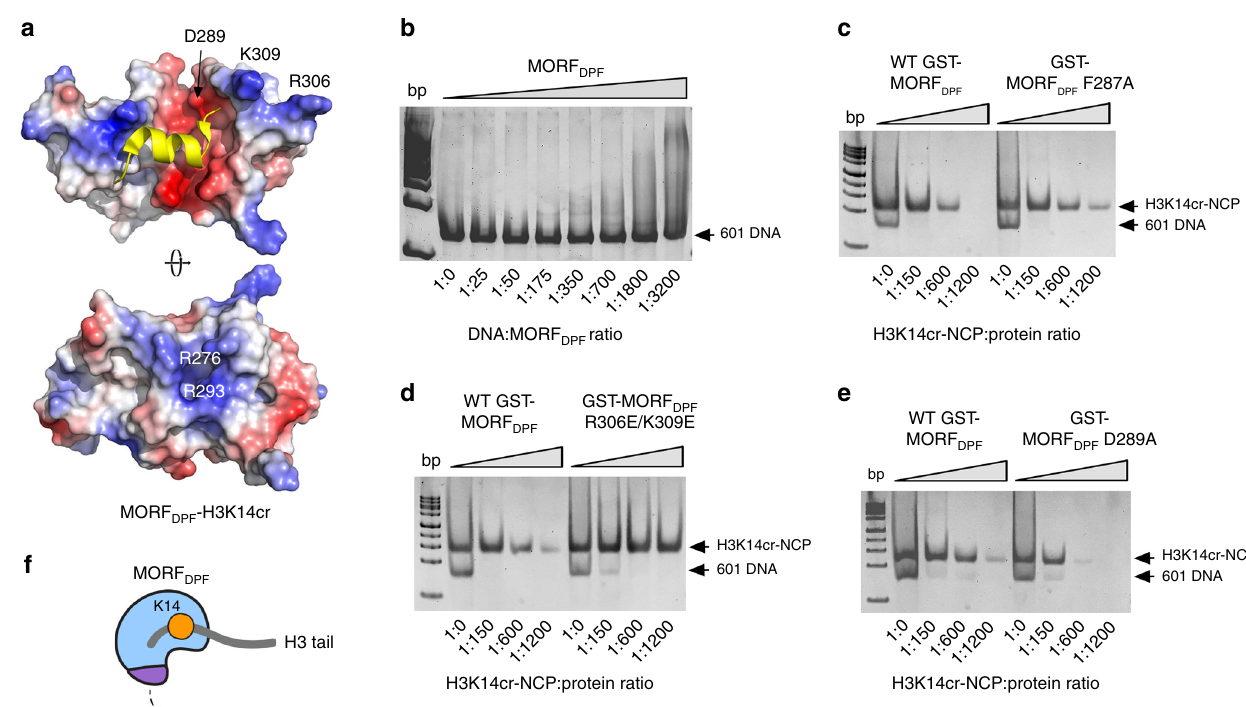
Fig. 5 MORF DPF has DNA-binding activity. a Electrostatic surface potential of the MORF DPF in complex with H3K14cr is shown. Blue and red colors indicate positive and negative charges, respectively. b EMSA of 147-bp 601 DNA incubated with increasing amounts of WT MORF DPF . DNA to protein molar ratio is shown below the gel image. c – e EMSA of H3K14cr-NCP incubated with increasing amounts of WT or mutant GST-MORF DPF . H3K14cr-NCP to protein molar ratio is shown below each gel image. f A schematic showing the dual interaction of MORF DPF with histone tail and